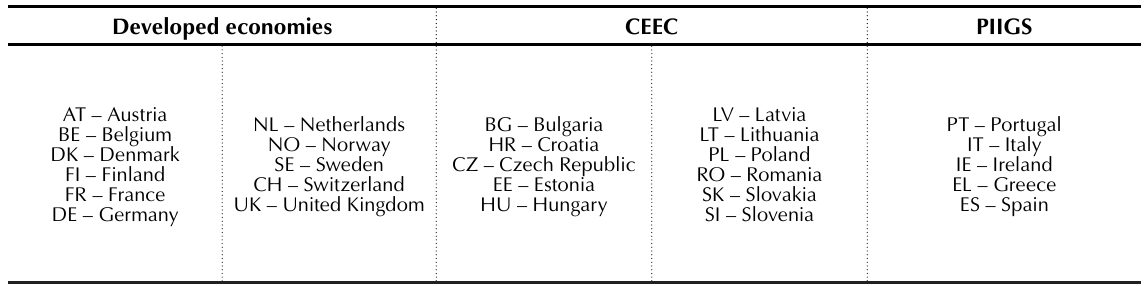
Table 1. Subsamples of European countries used for the